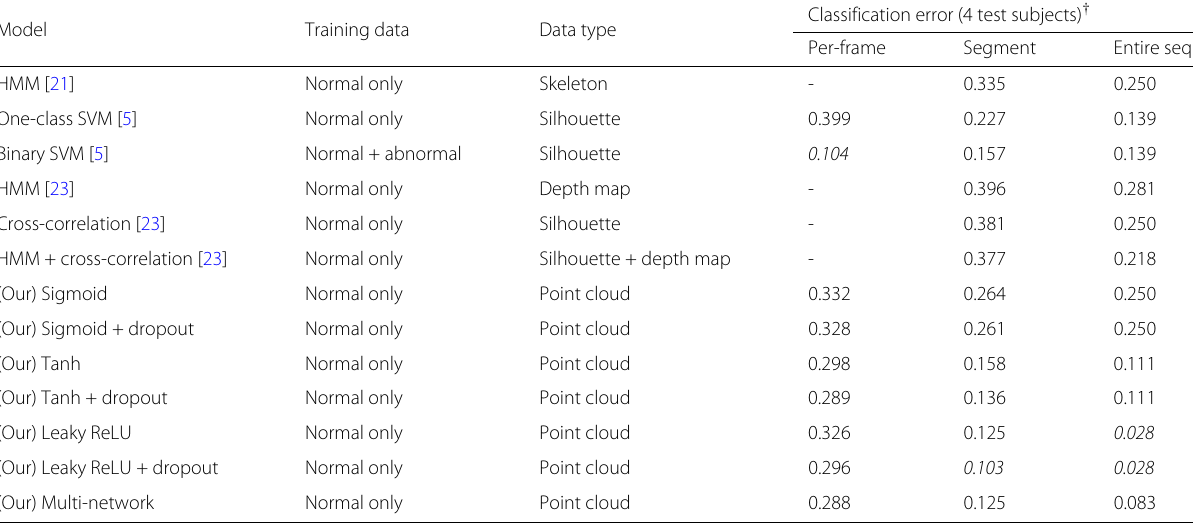
Table 2 Classification errors ( ≈ EERs) resulting from experiments on our auto-encoders and related studies with different data types Model